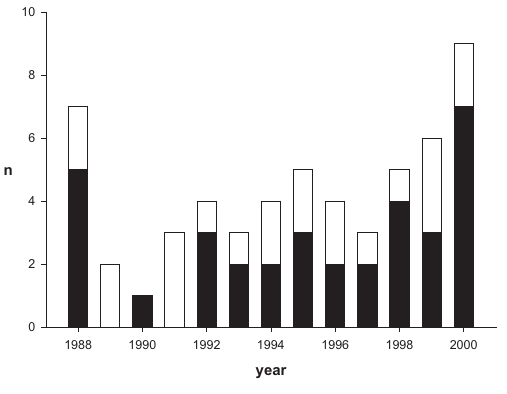
Distribution of the cases of RDS over observation period.